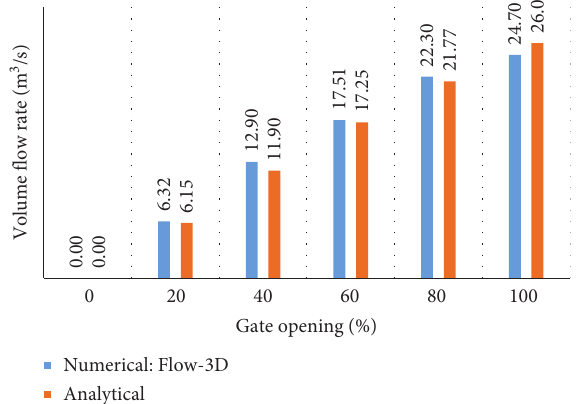
Figure 13: Output velocity of the gate and valve in 80% gate and 100% valve